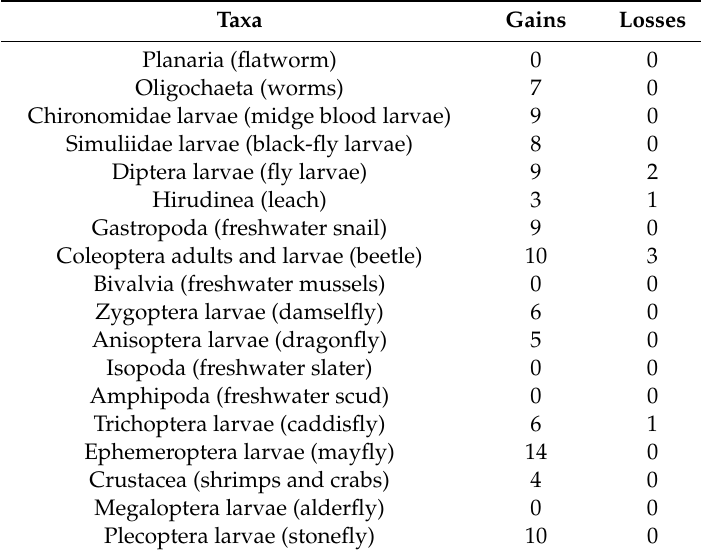
Table 4. Gains and losses of the identification audit, distributed by the surrogates. The vernacular names of the taxa are inside parentheses.